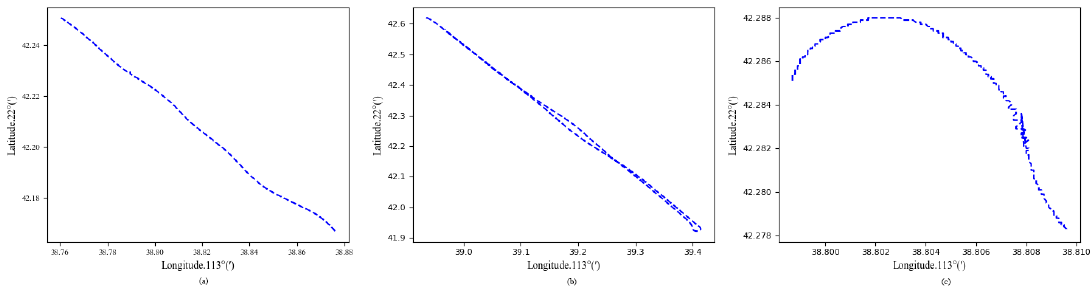
Figure 7. The trajectory history of “JingHai-III” test sets: ( a ) test set-1; ( b ) test set-2; and ( c ) test